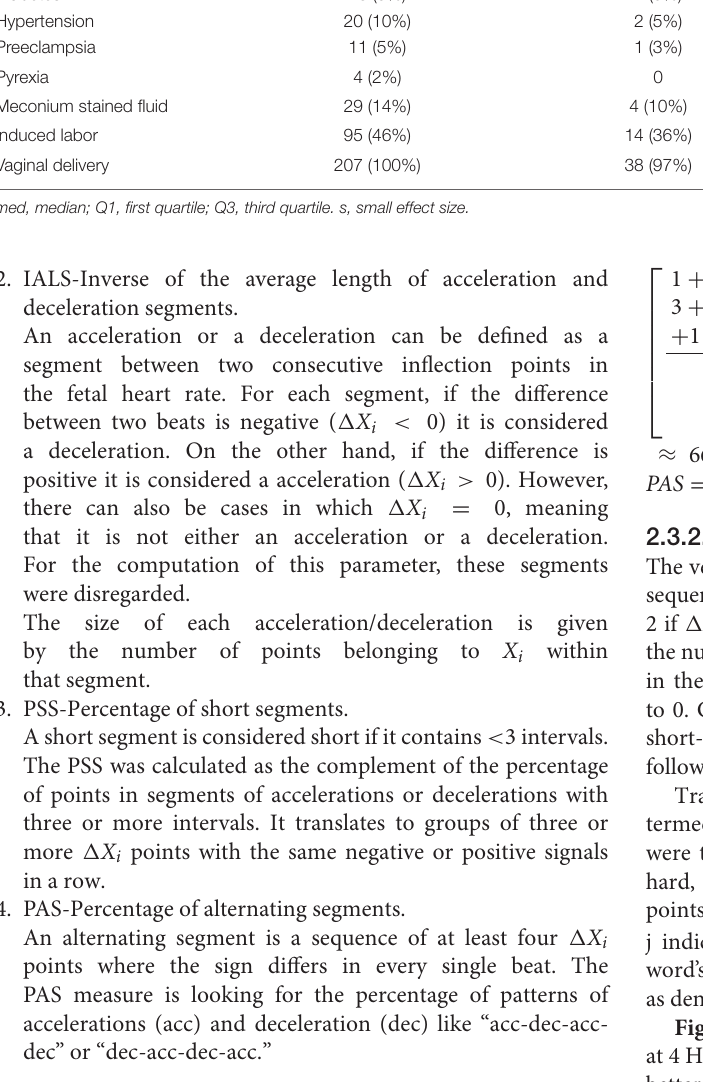
better illustrate the symbolic fragmentation indices